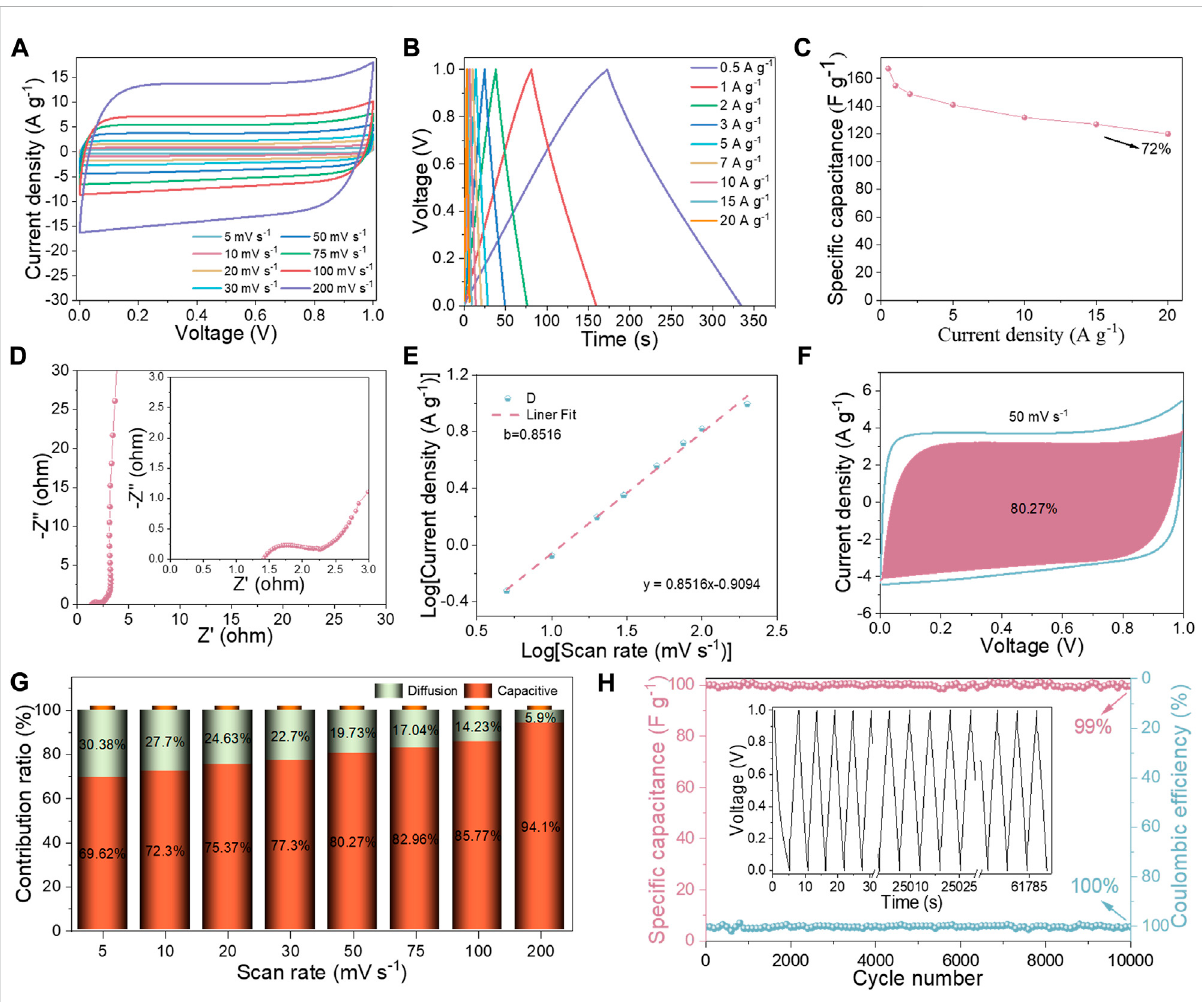
FIGURE 5 Electrochemical performance of the NSPC symmetric device in 6 M KOH electrolyte: (A) CV curves at different sweep rates, (B) GCD curves at different current densities, (C) NSPC Speci fi c capacitances at different current densities, (D) Nyquist plots, (E) linear plot of log i vs log v in charge processes, (F) capacitive contribution at 50 mV s − 1 , (G) diffusion- and capacitive-controlled contribution ratio at different scan rates, and (H) cycling stability and Coulombic ef fi ciency of NSPC at 20 A g − 1 (inset is GCD curves after 10,000